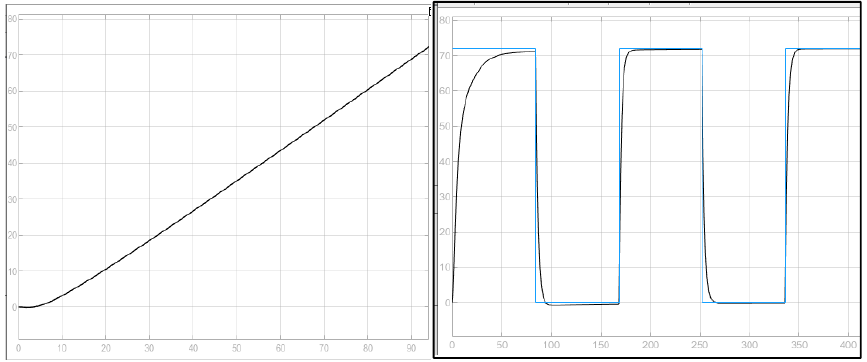
Figure 28. Response of the confection process to a ramp input and a pulse generator n = 5.